Question: Looking at the figure, what chart type is it?
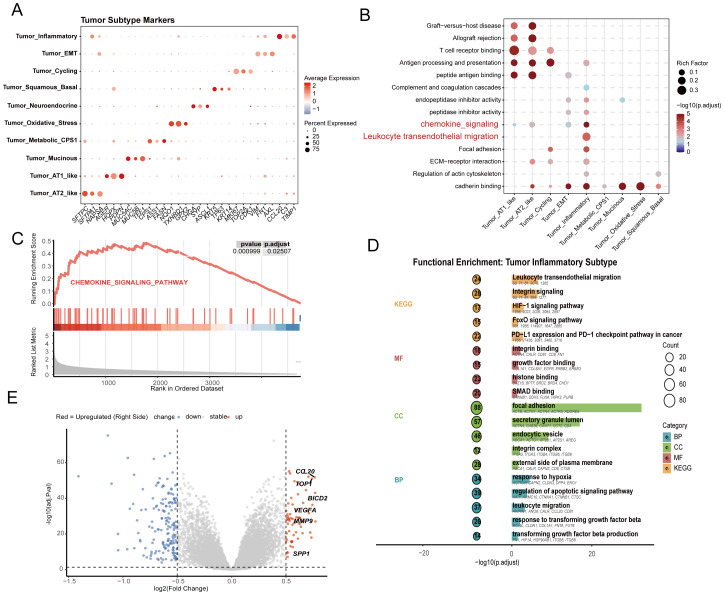
Answer: bar